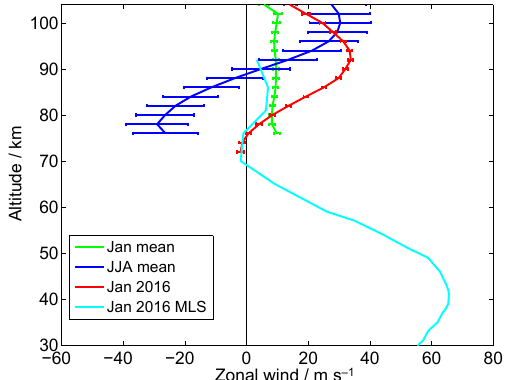
Figure 3. Vertical zonal wind profiles for the mean summer (June, July and August), mean January and for the summer-like conditions averaged between 26 December 2015 and 5 January 2016 at An- denes. The cyan-colored line shows the geostrophic winds derived from MLS around Andenes. The error bars for the mean summer profile show the geophysical variability and are representative for the other two profiles. The error bars given for the mean January (green) and January 2016 profiles are the statistical uncertainties, which are also representative for three profiles.